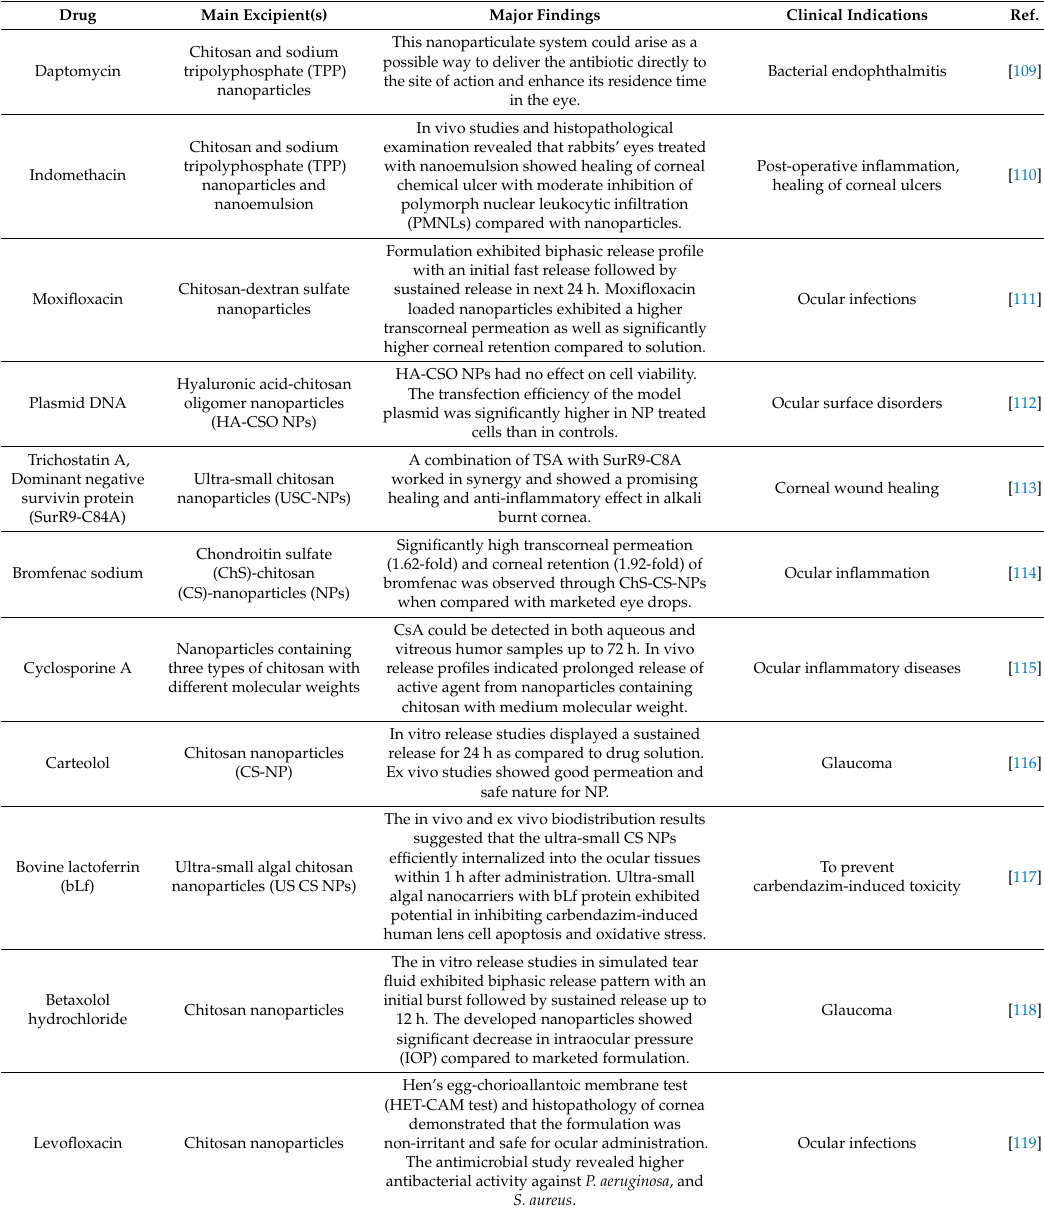
Table 1. Chitosan-based nanoparticles for ocular drug